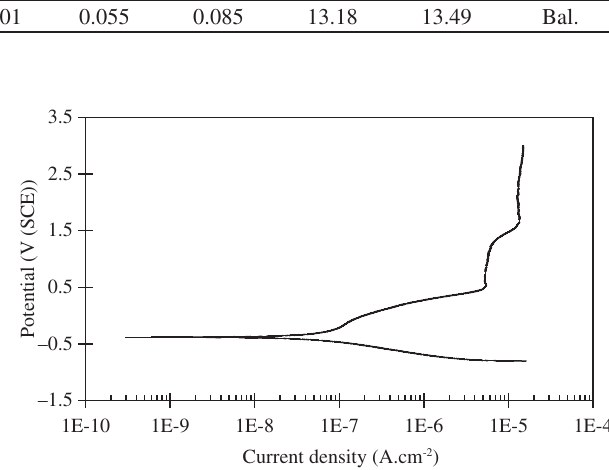
Table 1. Chemical composition of Ti-13Nb-13Zr alloy. Element